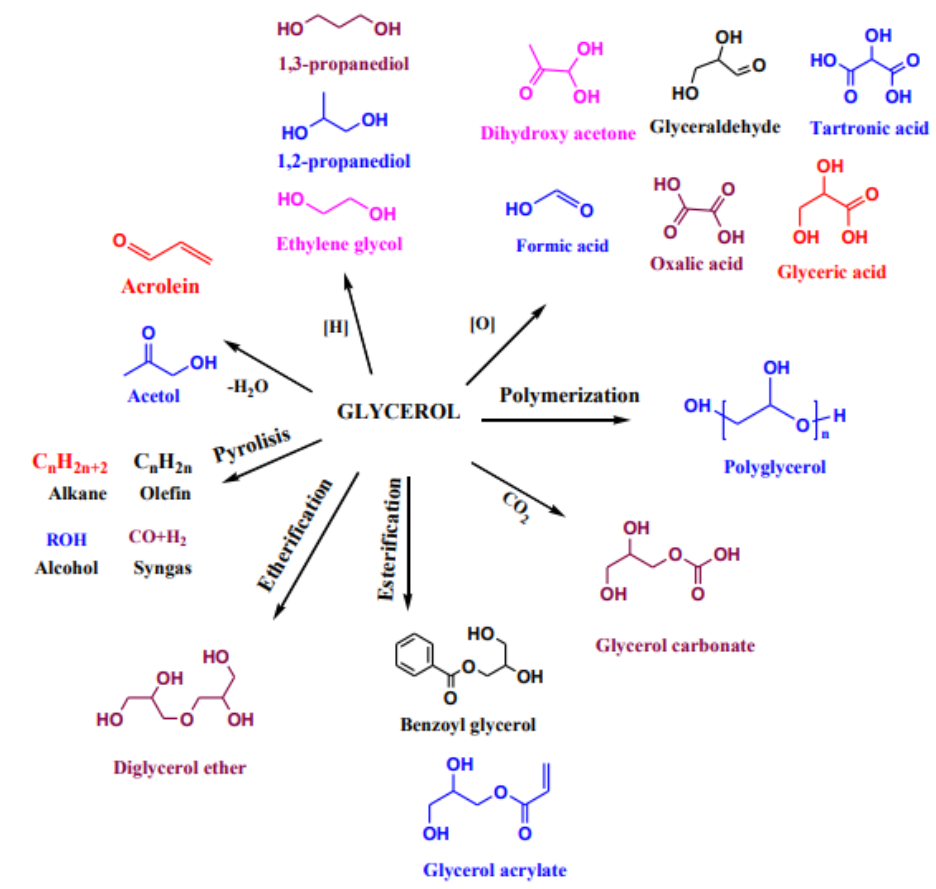
Figure 2. Various glycerol conversion pathways. Adapted with permission from Bartoli et al. [3], published by IntechOpen, 2019.